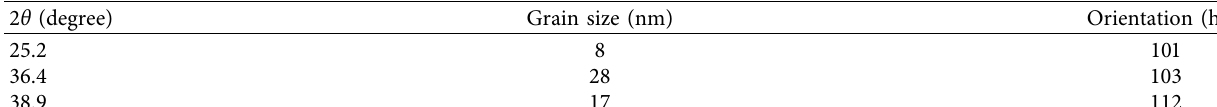
2 nanostructure.